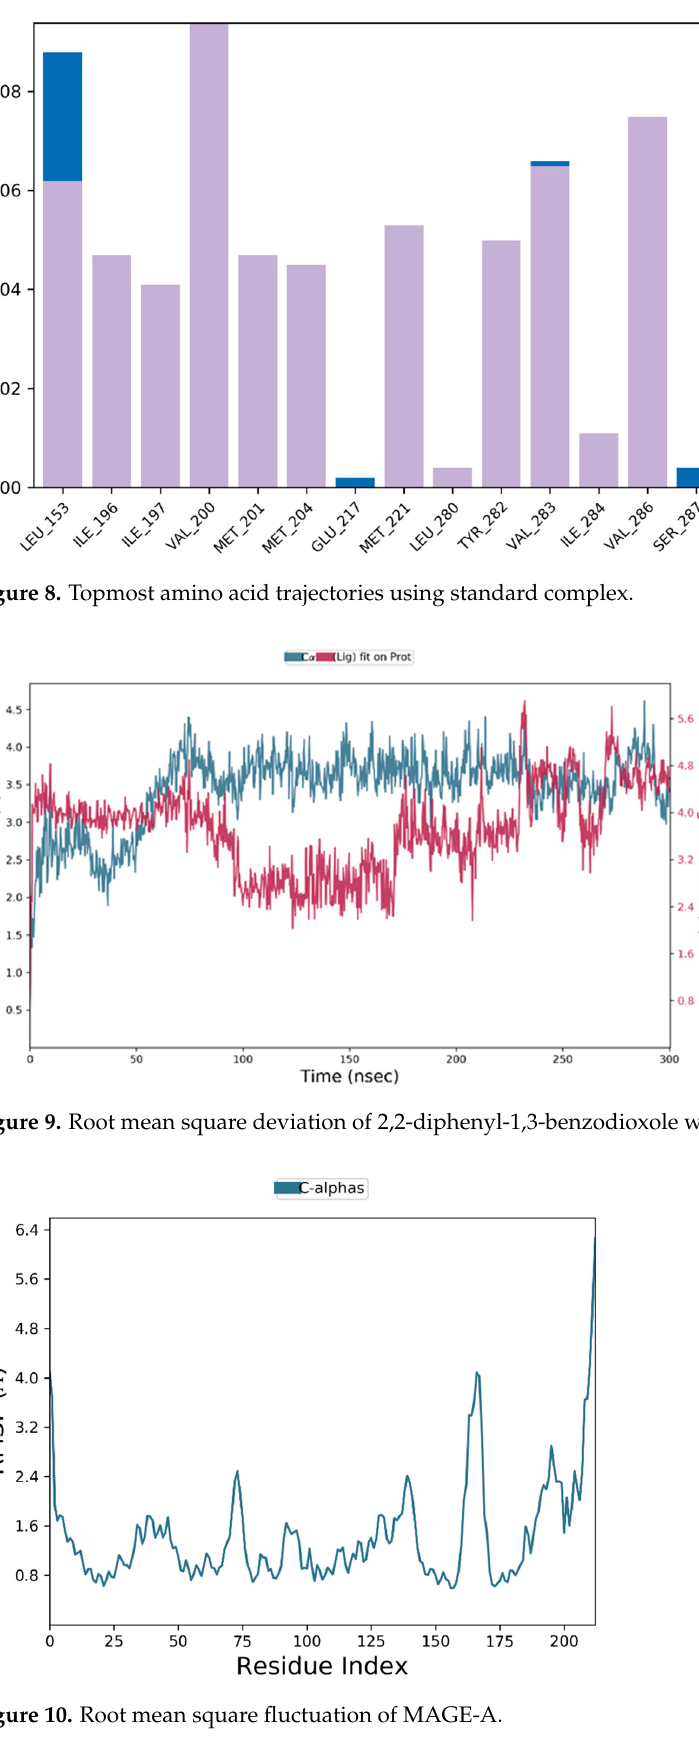
360 Figure 11. Protein secondary structure histogram .